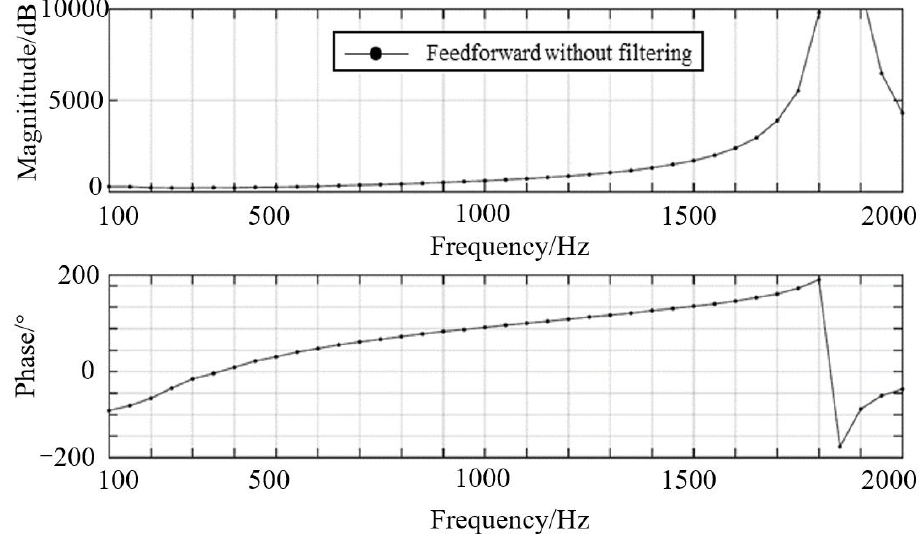
Figure 8. Impedance characteristics of back-to-back MMC-HVDC.